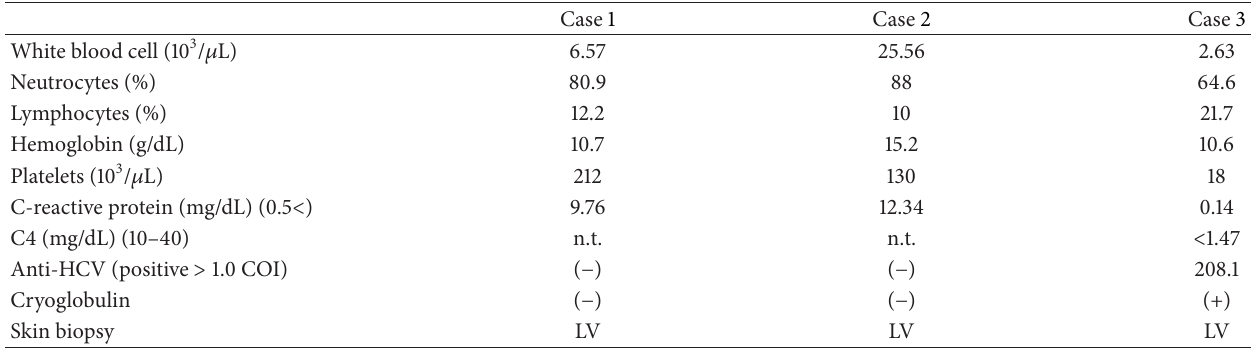
Table 1: Laboratory examination of three cases.